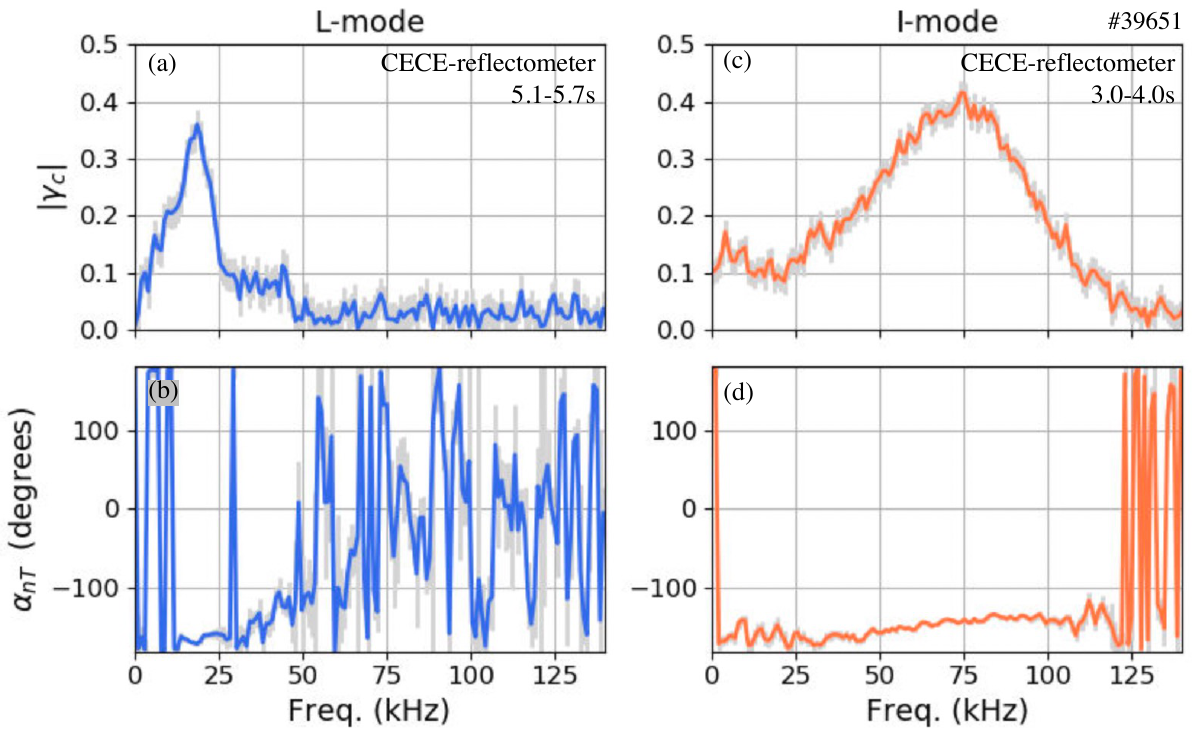
Figure 6. Coherency between a CECE channel and V-band reflectometer at ρ pol = 0 . 98 during (a) L-mode and (c) I-mode phases, showing the WCM at 20 kHz in L-mode and 40-100 kHz in I-mode. The n e T e phase over frequency obtained from CECE-reflectometer correlations shown in (b) L-mode and (d) I-mode. The n e T e phase at the spectral peak of the WCM is − 171 ◦ in L-mode and shifts to − 143 ◦ in